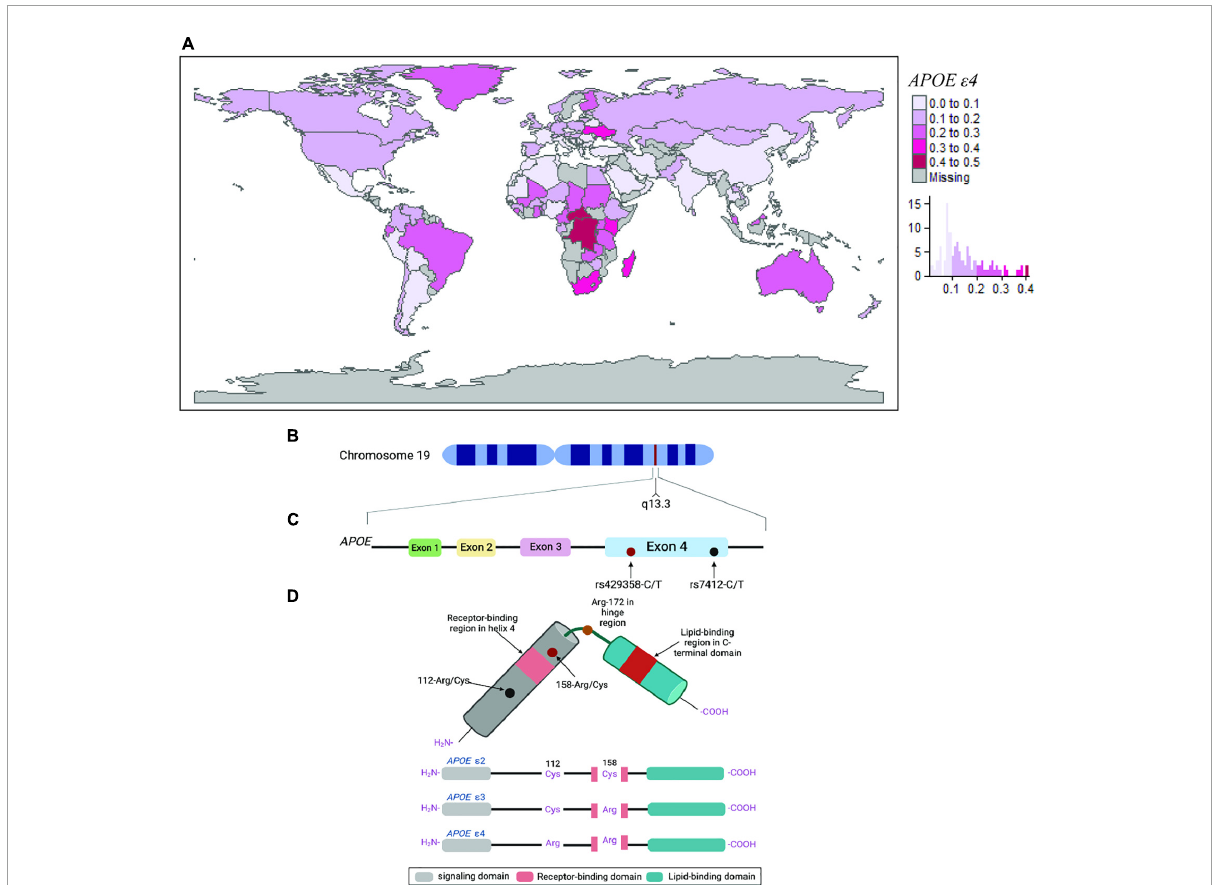
FIGURE2 The APOE ε 4 locus. (A) Worldwide APOE ε 4 allele frequency plotted by country and by histogram. Allele frequency estimates were obtained from Singh et al. (2006) and other literature search (see Supplementary Information ). (B–D) Schematic representation of the APOE ε 4 locus. (B) The structure and location of the APOE gene on chromosome 19. (C) Estimated structure of the APOE protein. (D) The three main APOE isoforms ε 2, ε 3, and ε 4, respectively, are the result of non-synonymous polymorphisms that cause amino acid changes at positions 112 and 158 of the APOE